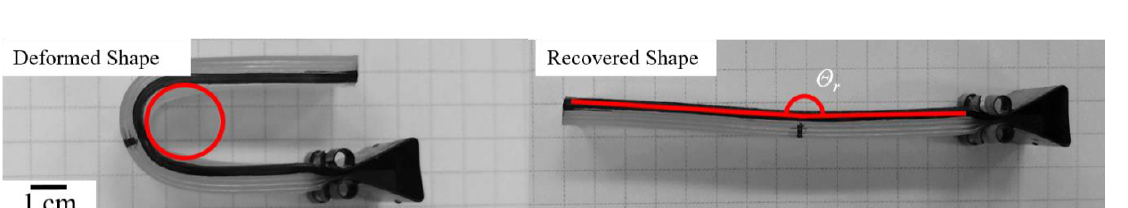
Figure 2. SMP samples for the fold-deploy test. Deformed sample ( left ) and recovered sample showing the recovered angle, θ r , ( right ). The black line on the sample was drawn on the coupons as the angle reference for measurement.